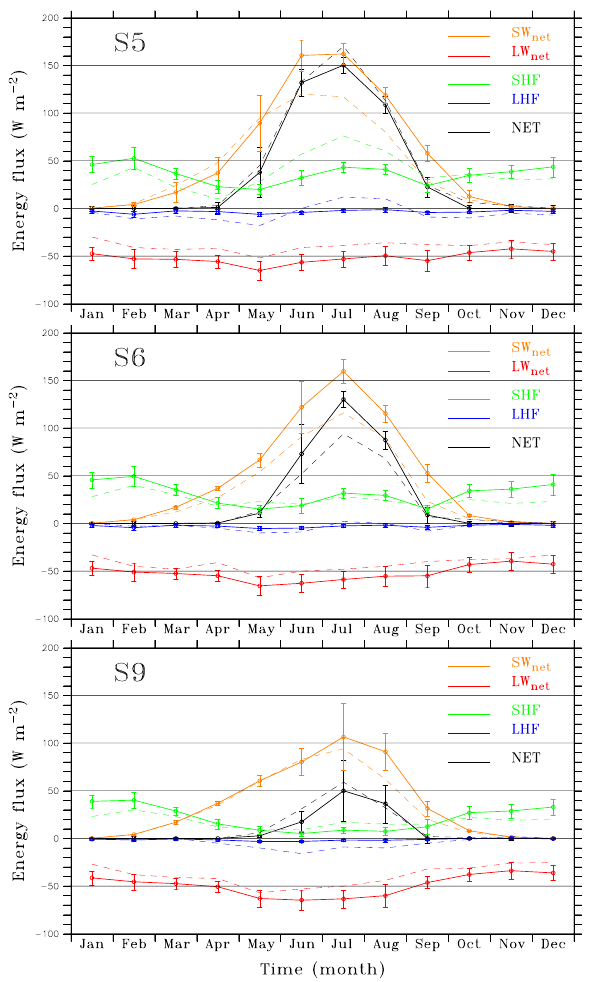
Fig. 1. Average seasonal cycle of SEB components (Wm − 2 ) sim- ulated by the MAR model forced by the ERA-Interim reanalysis (in solid lines) over a 7-yr period (September 2003–August 2010) along the K-transect at sites S5, S6 and S9, with standard deviation over this period indicated by the error bars. Observations from the AWS available in van den Broeke et al. (2011) are drawn in dashed